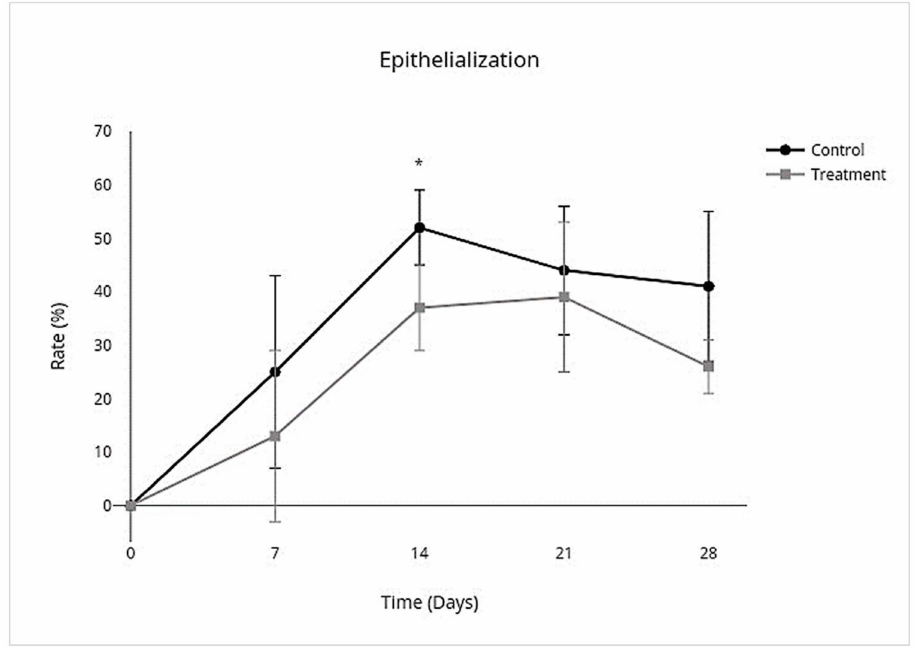
Figure 5. Total area (%) of epithelialization contributing to wound closure of limb wounds. There was an overall decrease in total epithelialization over all days with individual treatment effect on day 14 ( p = 0.02). (*) = p <